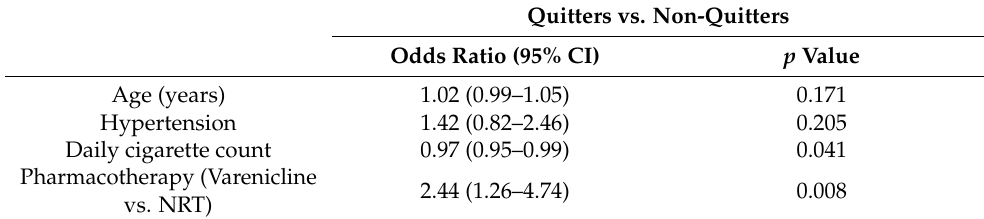
Table 3. Odds ratio (95% confidence interval) among quitters and non-quitters’ groups with logistic regression